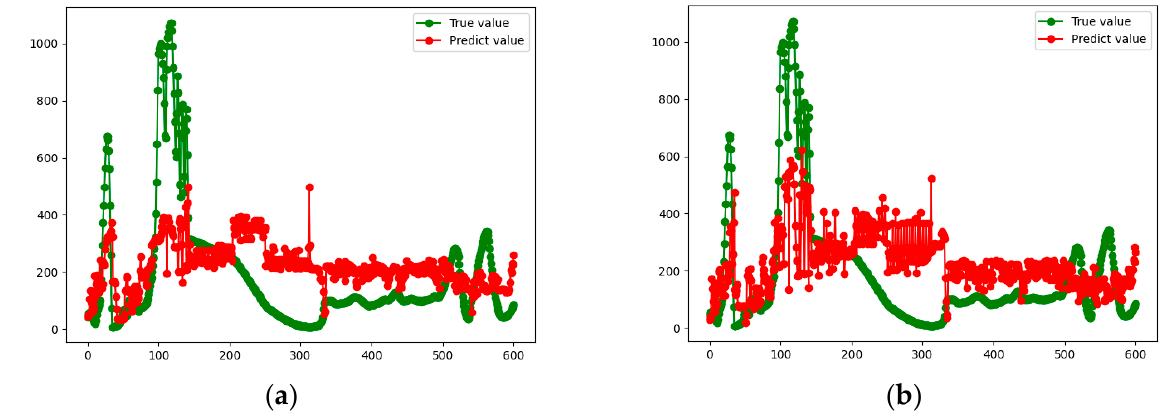
Figure 10. The prediction results by RF ( a ) and GBDT ( b ) for the vehicle of ***9630.